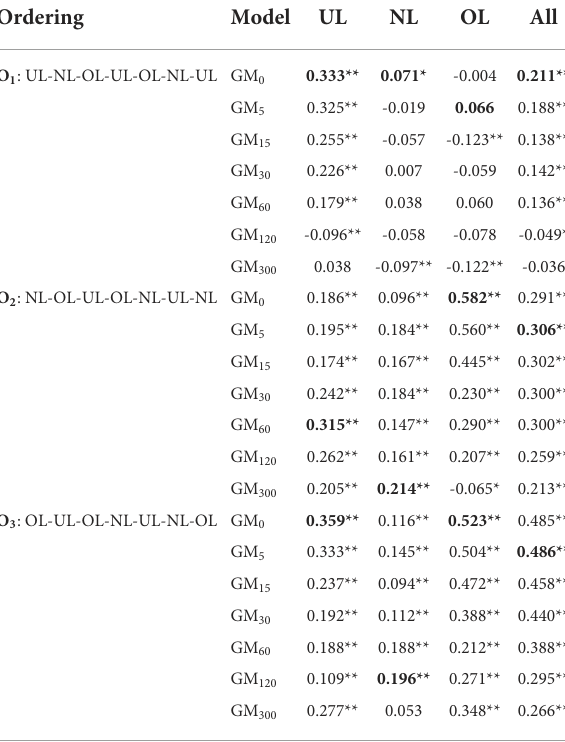
TABLE 1 The predicted performance mean absolute error (MAE) for each generalized model variant by workload condition and ordering. Ordering Model UL NL OL All